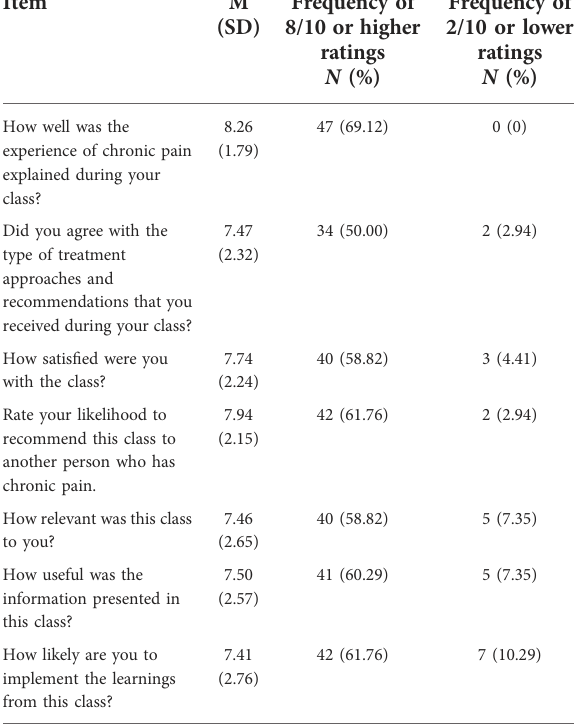
TABLE 4 Treatment satisfaction